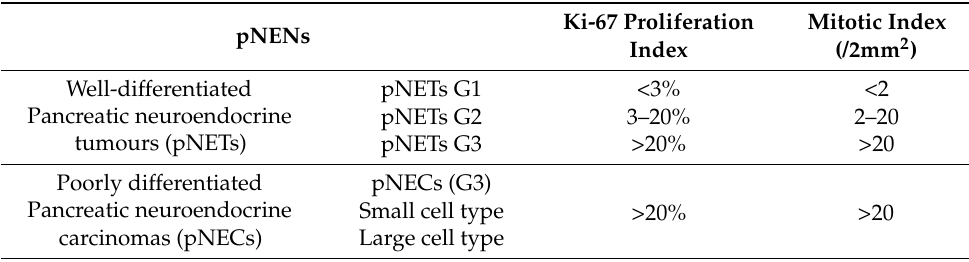
Table 2. World Health Organization (WHO) classification and grading of pancreatic neuroendocrine neoplasms (pNENs)